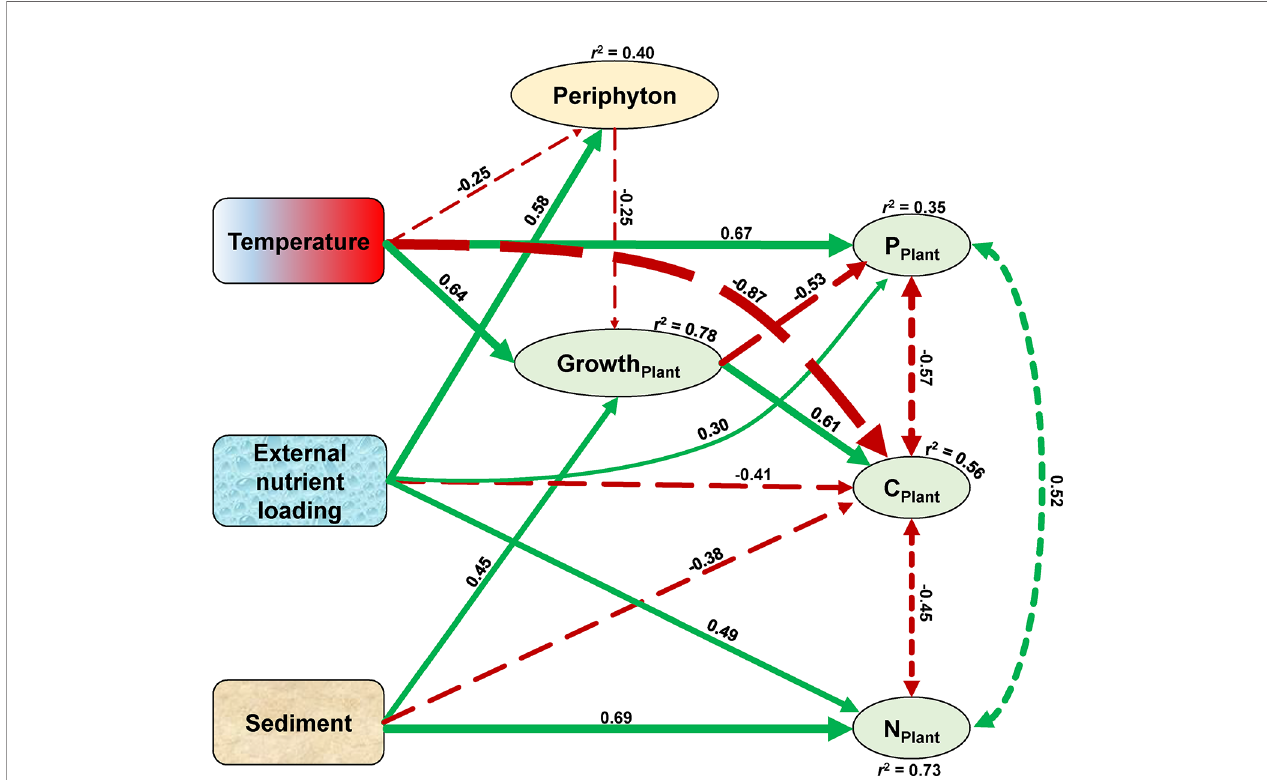
FIGURE 7 | Structural equation model (SEM) of temperature, sediment, and external nutrient loading treatment effects on the growth and elemental compositions of the plant. Exogenous variables are indicated by rounded rectangles, and endogenous variables are represented by ovals. Coef fi cients of determination (r 2 ) are shown for all endogenous variables. Numbers adjacent to arrows are standardized path coef fi cients and indicative of the effect of the relationship. Positive and negative effects among variables are depicted by green solid and red long-dashed arrows, respectively, with arrow thicknesses proportional to the strength of the relationship. Covariance between the plant elements are depicted by dashed double-headed arrows. The covariance between N and P content of the plant marginally signi fi cant at p = 0.06, all other relationships in the model are signi fi cant at p < 0.01. The model satis fi ed each of the three model fi t criteria with signi fi cant c 2 of p = 0.35, standardized root mean squared residuals of 0.04, and comparative fi t index values of